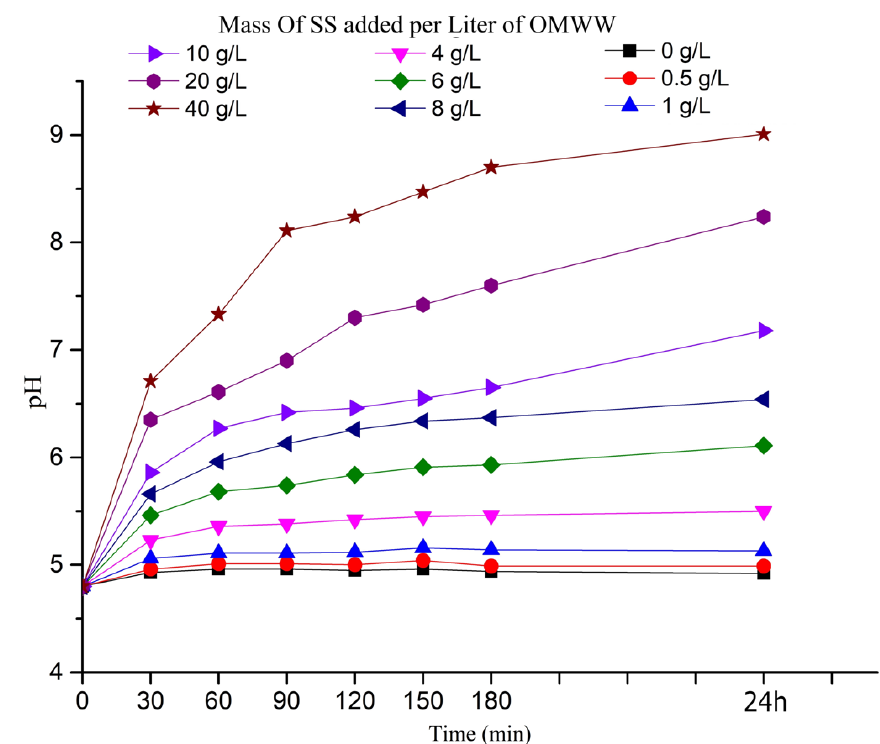
Figure 5. pH variation of OMWW as a function of time and steel slag dosage.